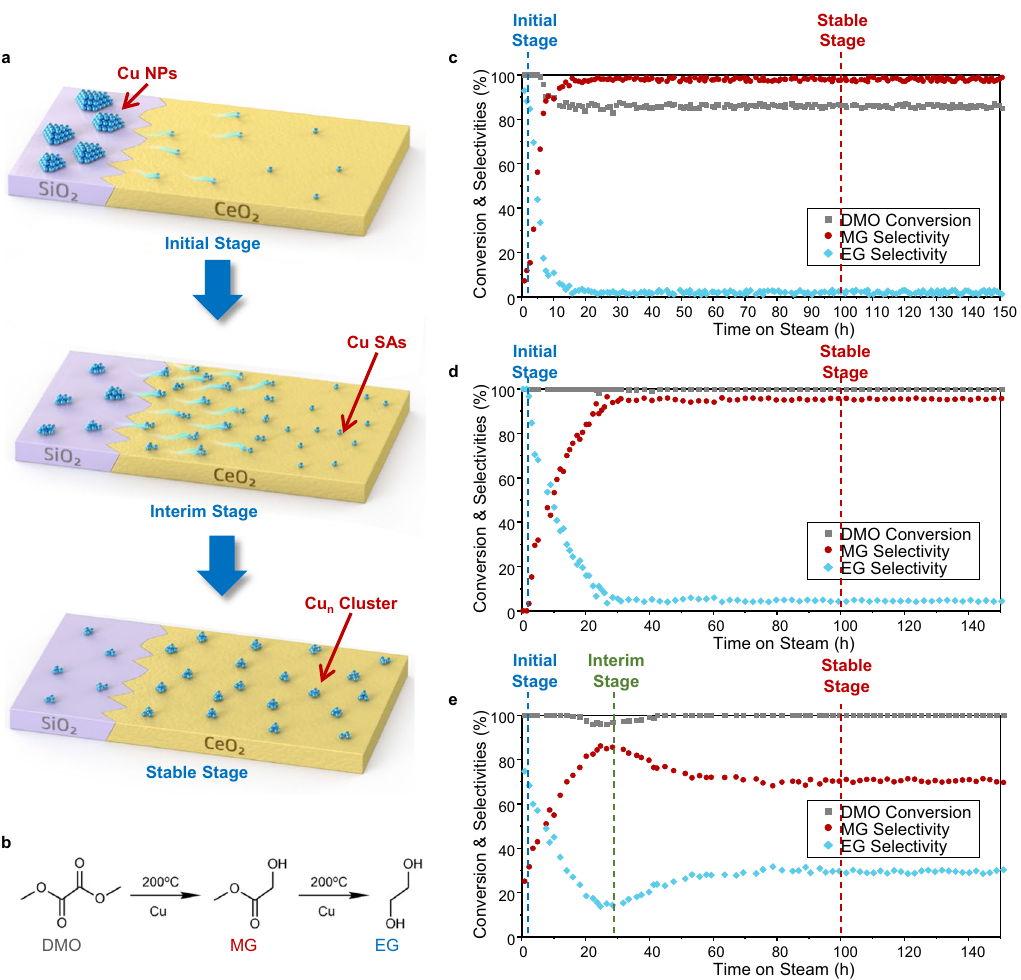
Fig. 1 | Cu atomic thermal diffusion process and its in fl uence on catalytic per- formance in long-term DMO hydrogenation. a Scheme of Cu atomic thermal diffusion process in forming clusters. b Scheme of the consecutive hydrogenation of DMO to MG and EG. c – e , Catalytic performance of 3Cu ( c ), 5Cu ( d ), 7Cu ( e ) in long-term DMO hydrogenation. Reaction conditions: 200°C, WLHSV Cu =6h − 1 , H 2 /